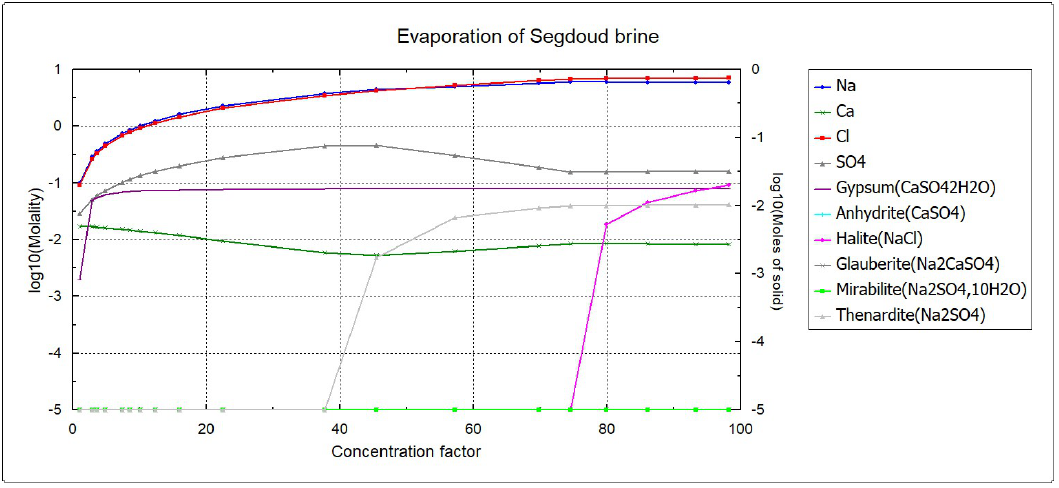
Figure 1. PHREEQC Batch reaction calculations.